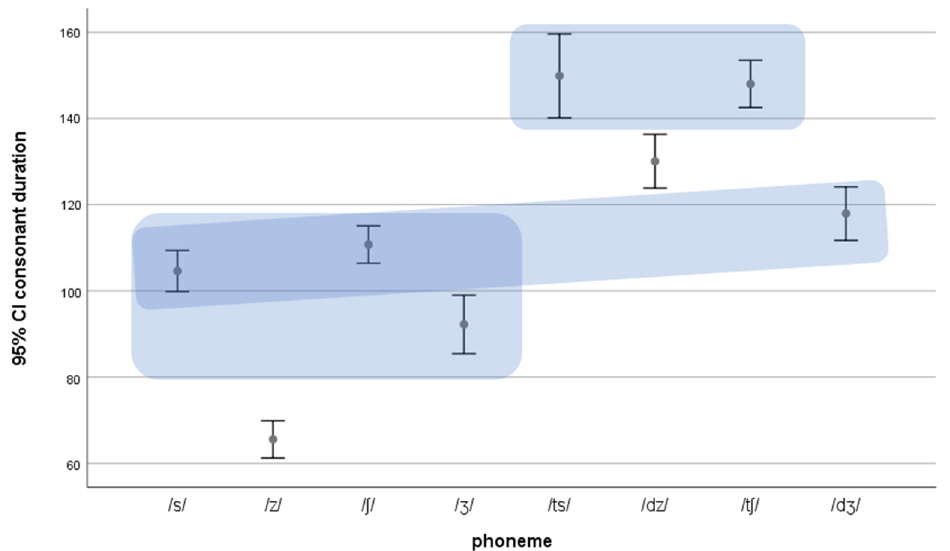
Figure 5. Error bar with duration values for every Catalan sibilant category. Blue shades indicate statistical similarities among the categories.